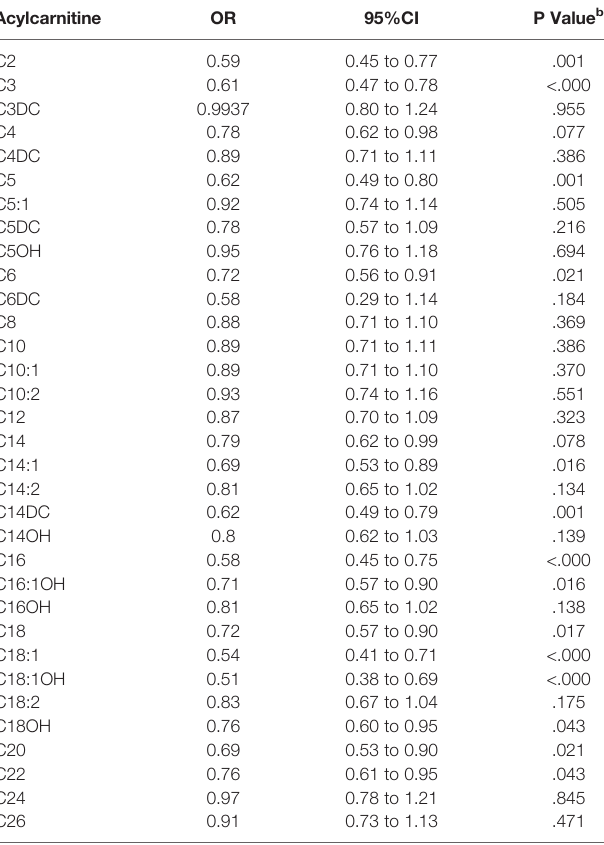
TABLE 4 | OR of Acylcarnitine for DR risk in T2DM (Multivariable model) a . OR 95%CI P Value